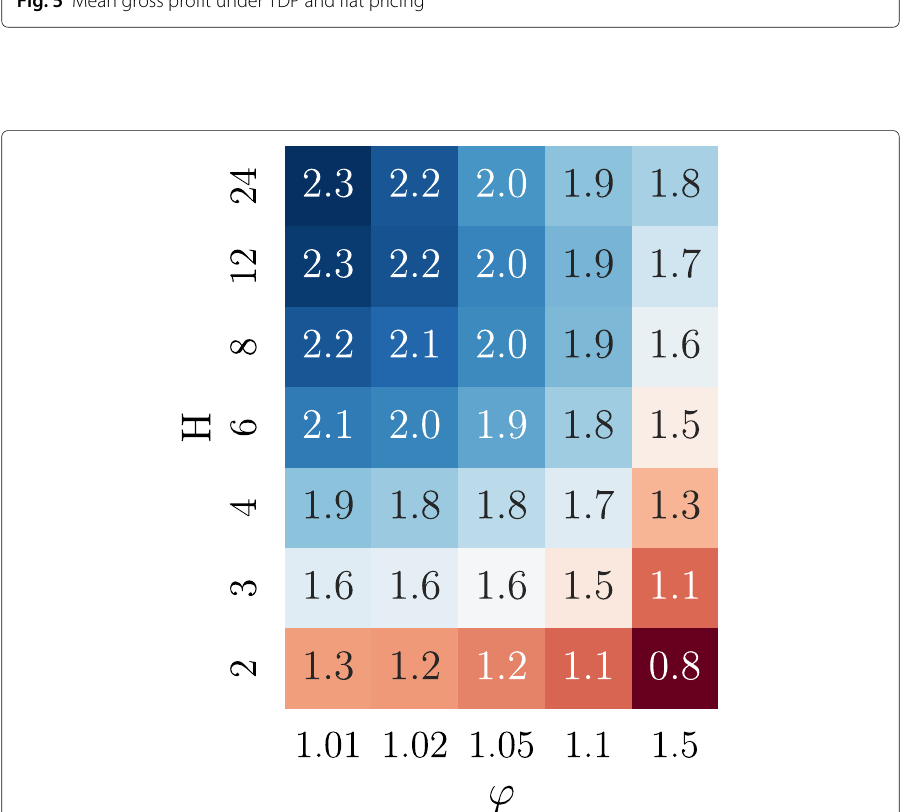
Fig. 5 Mean gross profit under TDP and flat pricing